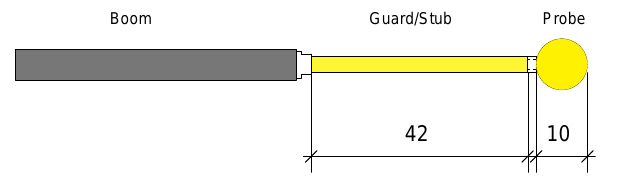
Fig. 4. The probe assembly showing the dimensions of the different parts.